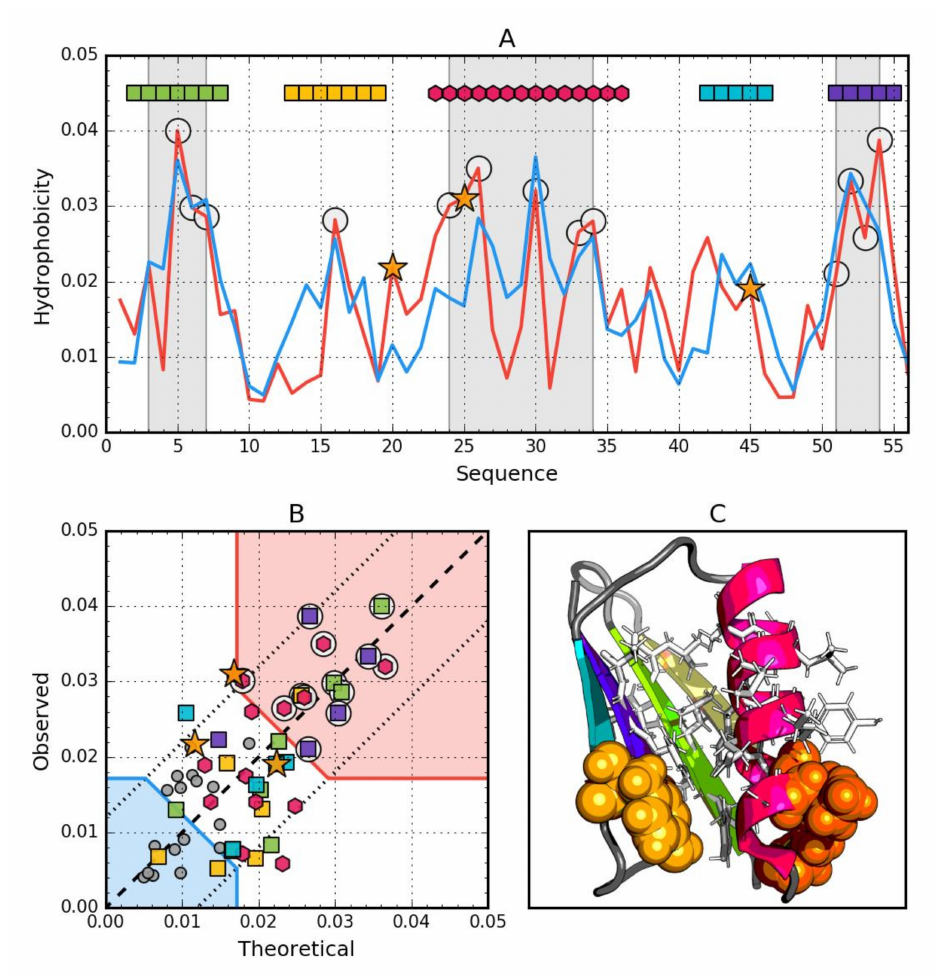
Figure 5. Hydrophobic properties of Gb98-T25I,L20A (2LHE). ( A ) theoretical—blue and observed—red hydrophobicity density profiles. Markers at the top denote individually colored elements of the secondary structure: Hexagons—alpha helices, squares—beta strands. White circles mark the location of hydrophobic core as determined by the FOD model. Gray-shaded regions encompass contiguous sequence fragments containing this core (combined with Gb98-L45Y data). Orange star locates the mutations (L20A, T25I, L45Y). ( B ) theoretical and observed hydrophobicity density scatter plot. Red shade—hydrophobic core zone, blue shade—hydrophilic surface zone. Markers denote the same residues as markers on A, except for small dark gray circles which are hydrophobicity parameters of unstructured fragments. Dashed line—theoretical and observed value equality line. Dotted lines—theoretical and observed value similarity threshold. ( C ) 3D presentation of the molecule. Secondary structure are distinguished using the same colors as on A. Hydrophobic core fragments are shown as white sticks, while mutations are shown as orange